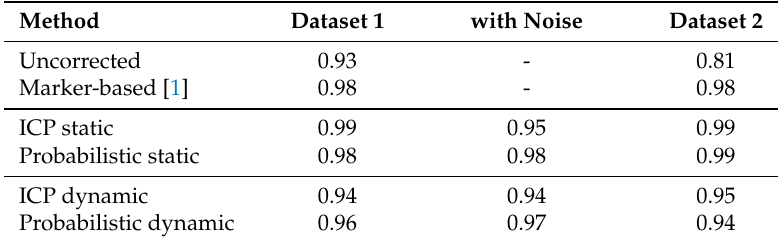
Table 1. Structural Similarity (SSIM) results of the reconstructed images for dataset 1 and dataset 2.